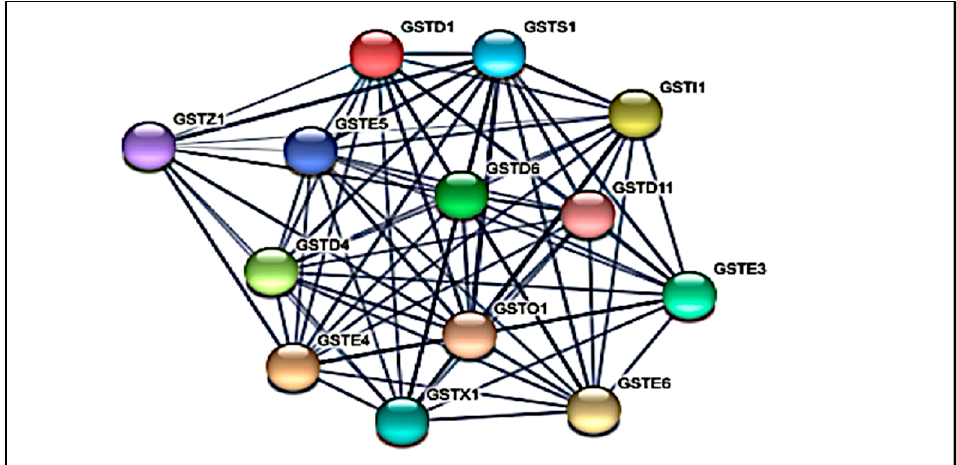
Figure 2. The interactive network view among Aedes GSTs of predicted protein-protein interaction analysis using STRING 11.5 tool. No. of nodes: 13; no of edge: 12; average node degree: 11.7; average local clustering coefficient: 0.977; PPI enrichment p -value < 1.0 × 10 − 16 .